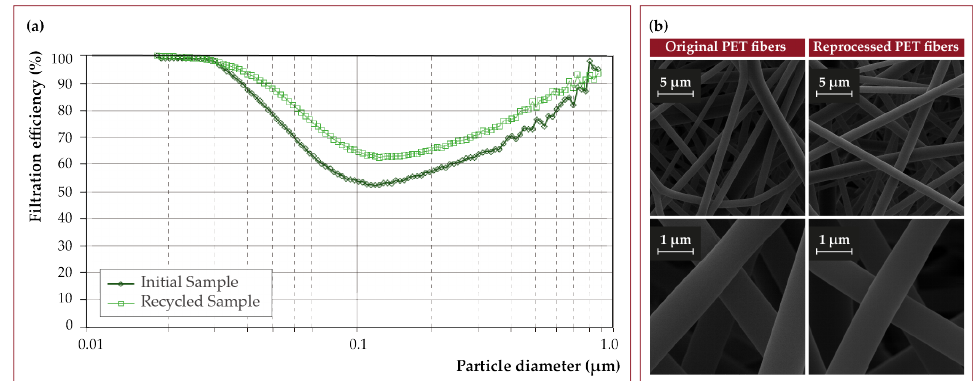
Figure 12. ( a ) Filtration efficiency of an initial PET fabric sample versus recycled (re-electrospun) PET fabric from an equivalent surgical mask and ( b ) SEM views of the PET fibers after